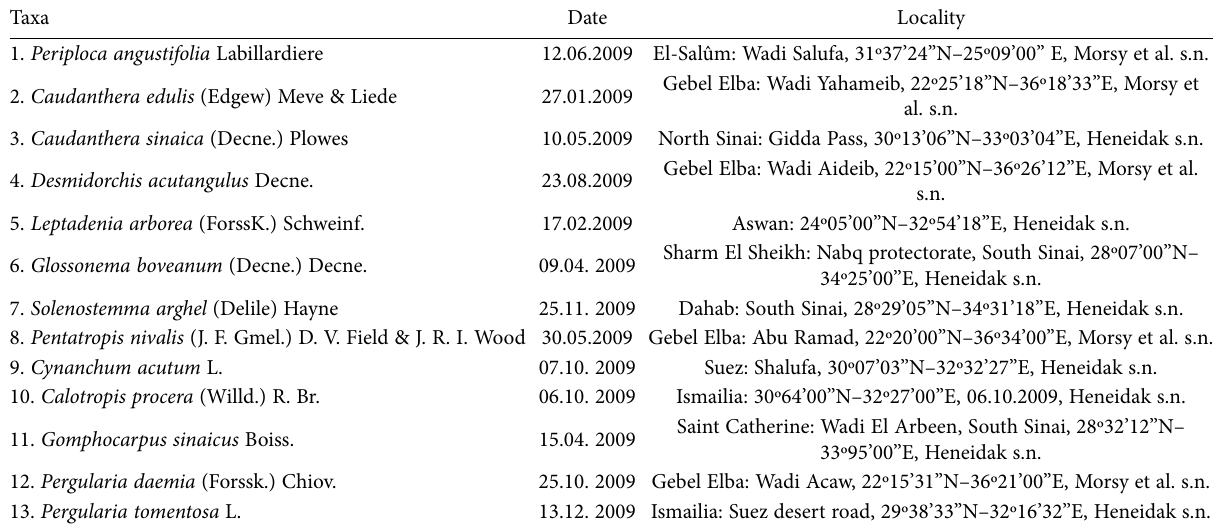
Table 1. List of species examined and the localities from which plants used for chromosome counts were collected and date of collection.